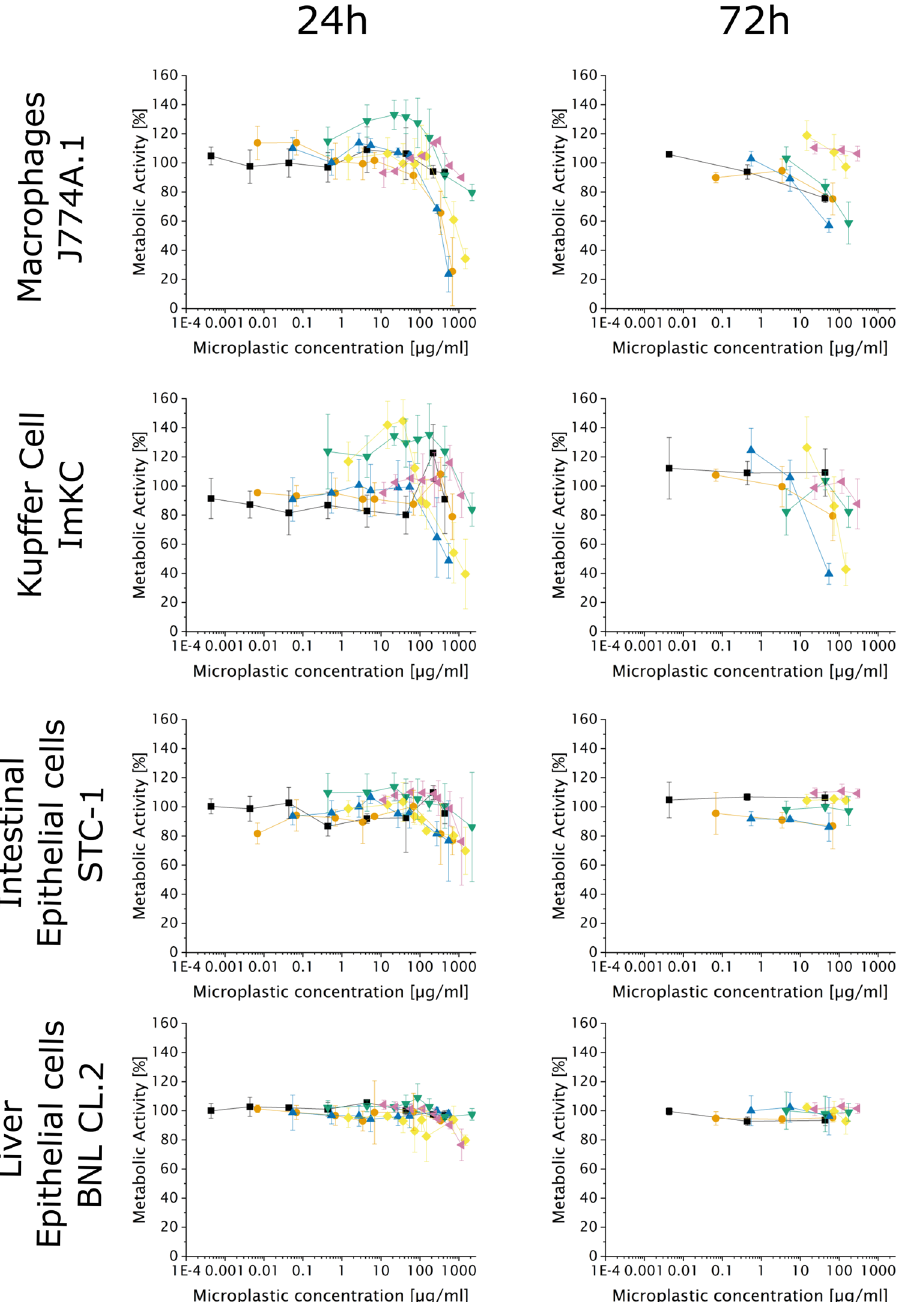
Figure 3. Cell metabolic activity after 24 h and 72 h in the presence of MPP. The metabolic activity was determined using the MTT assay in correlation to cells without particles acting as negative control. Data represent mean ± SD, n = 3 biological replicates. Particle sizes: black square = 0.2 µm, orange circle = 0.5 µm, blue triangle = 1 µm, green down-pointing triangle = 2 µm, yellow diamond = 3 µm, purple left-pointing triangle = 6